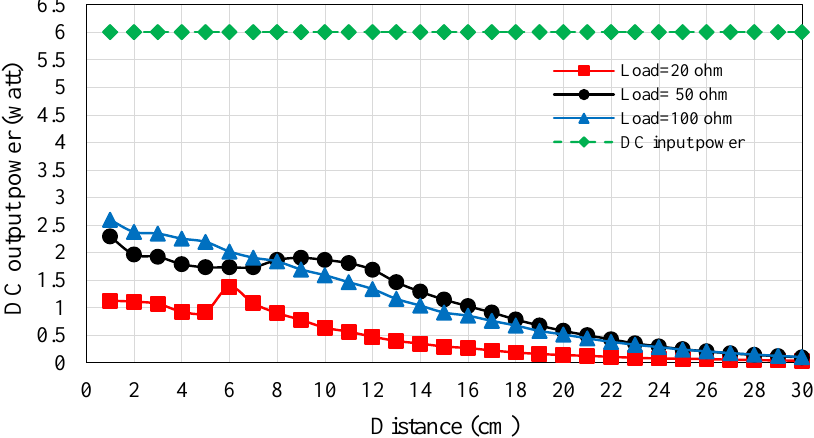
Figure 14. The relationship between output power and transfer distance.